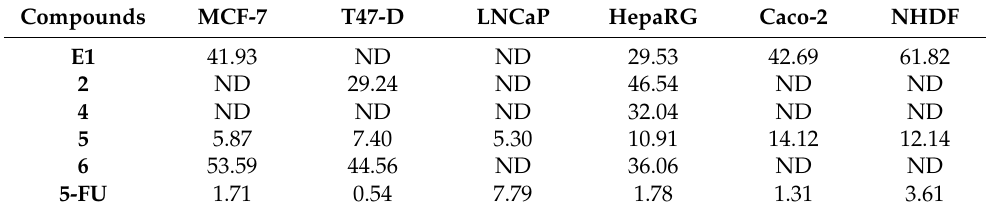
Table 2. Selectivity index (SI) a of compounds 1 , 5 and 5-fluorouracil (5-FU). Compounds Table 1. IC 50 (µM) of compounds 2, 4 – 6 and 5-fluorouracil (5-FU) against MCF-7, T47-D, LNCaP, HepaRG, and Caco-2 cancer cells and normal fibroblasts (NHDF) a . Compounds